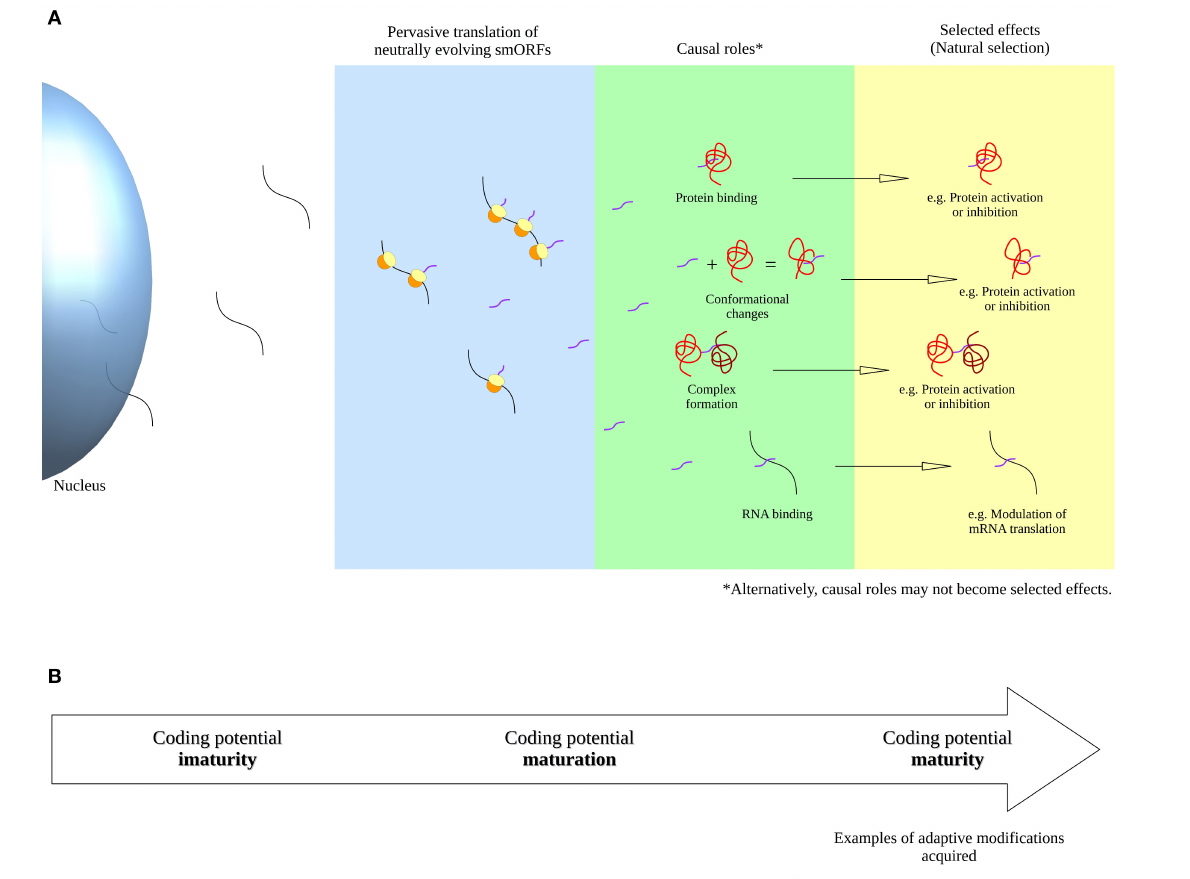
FIGURE 1 | Phenotype selection and coding potential maturation of smORF transcripts. (A) Transition of smORF peptides from “causal roles” to “selected effects” after pervasive translation events. Pervasive translation of neutrally evolving smORFs possibly advances proteome evolution by exposing neutral